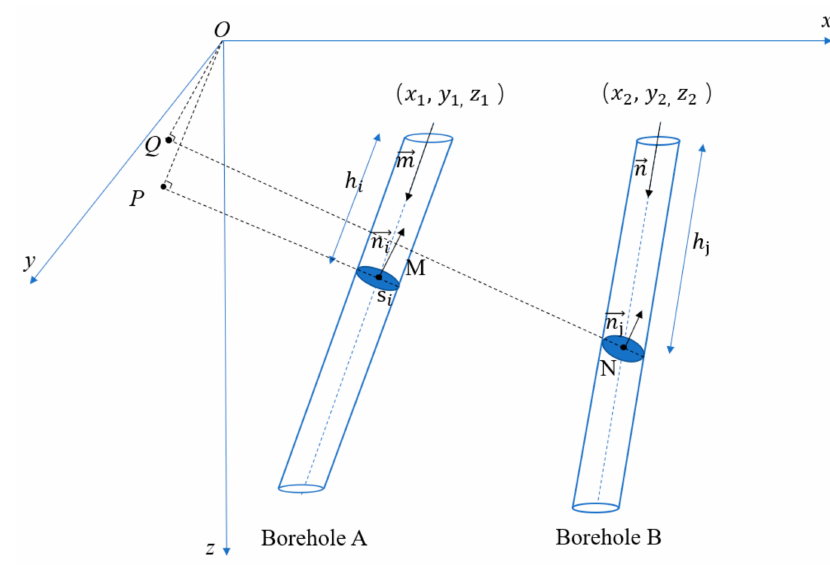
Figure 3. Consistency analysis diagram of the structural plane in